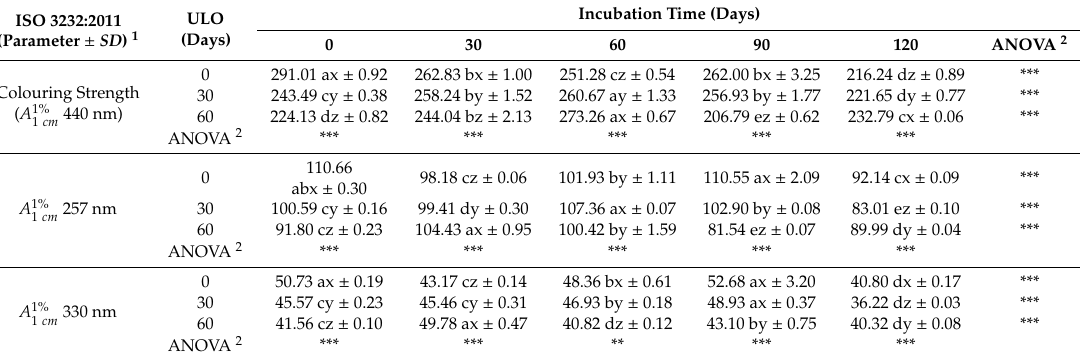
Table 4. Mean value and standard deviation for the ISO 3632:2011 parameters analysed of sa ff ron obtained from corms lifted in vegetative stage V3–20 d and stored di ff erent times in ULO followed by di ff erent incubation